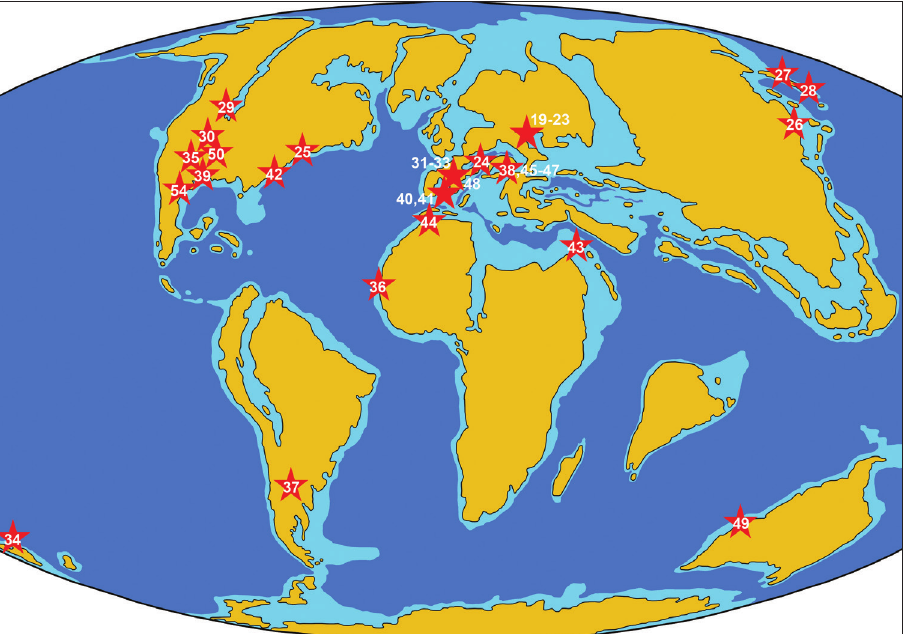
Figure 6. Paleogeographic map of the latest Cretaceous (65 Ma) showing Campanian-Maastrichtian-age localities of azhdarchids. The numbers of localities correspond to the list in the text. The map is modified from